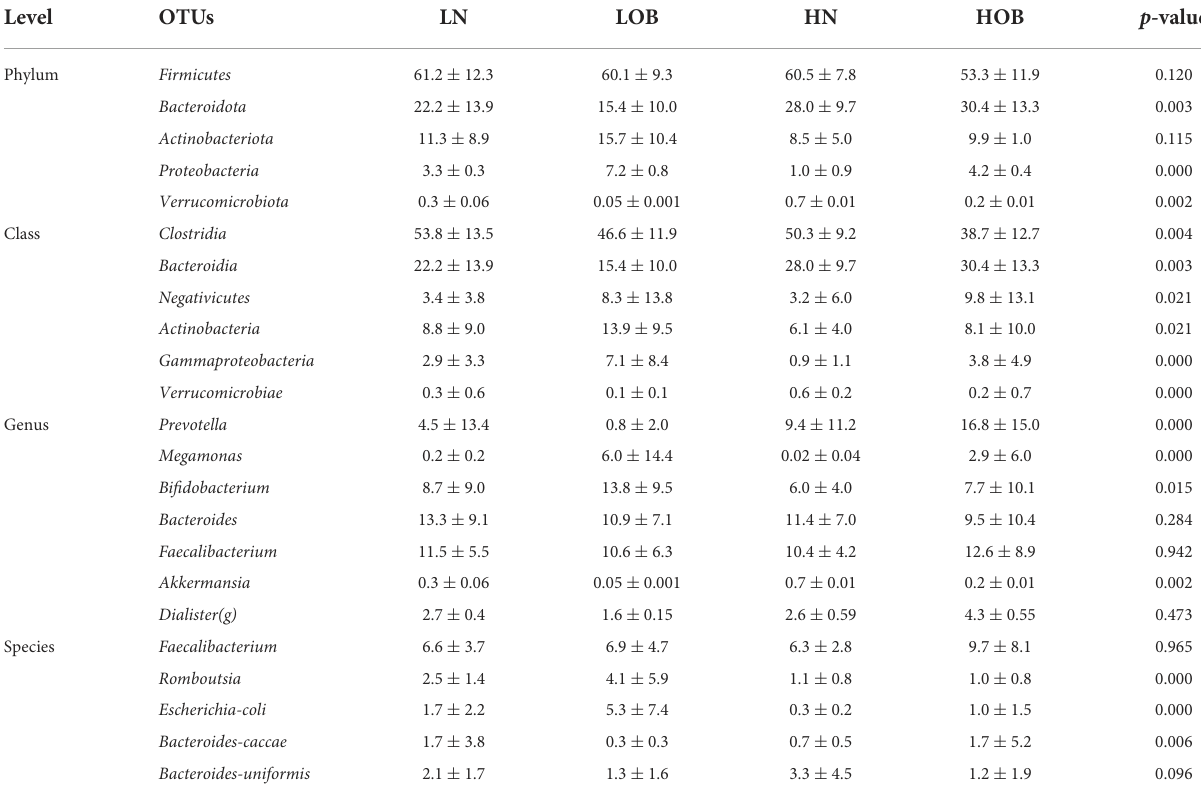
TABLE 4 Comparison of dominant OTUs in four groups at different